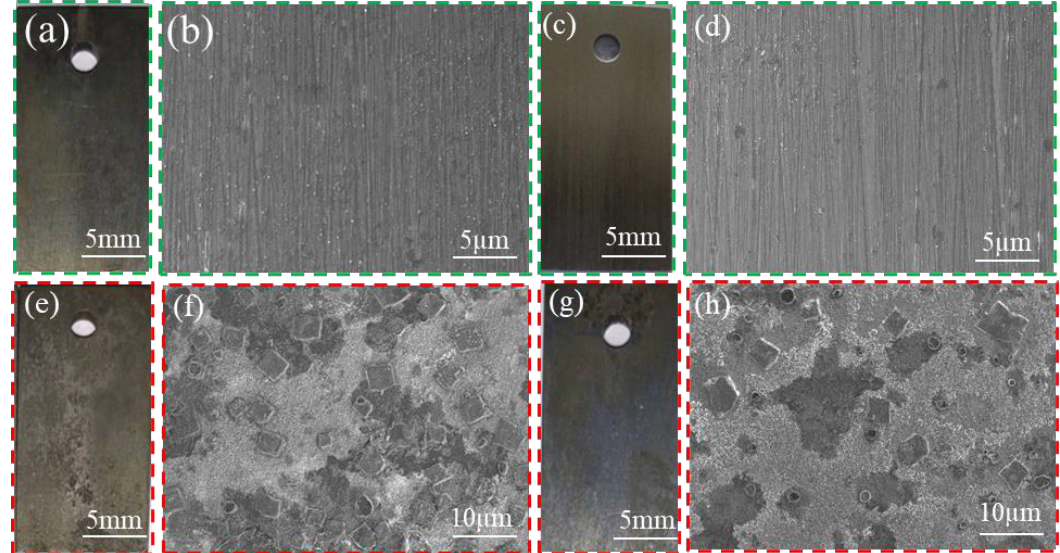
Figure 15. Macroscopic morphology and micromorphology of P110ss in corrosive solution prepared with water-based annular protective solution prepared with clear water ( a – d ) and formation water preparation ( e – f ) (liquid phase: ( a , b , e , f) ; gas phase: ( c , d , g , h) ).